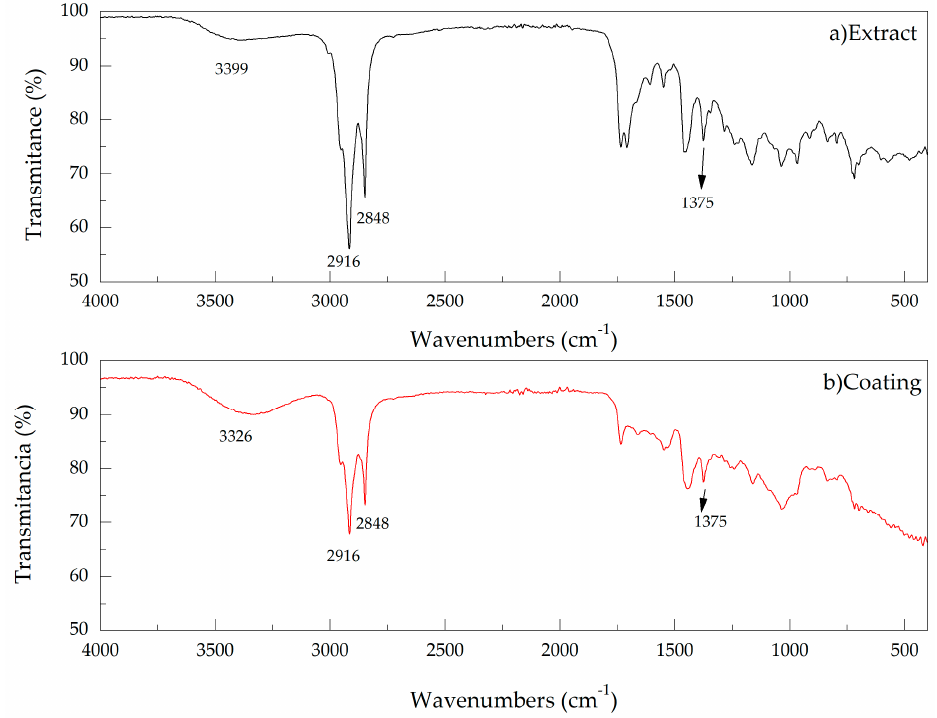
Figure 3. FTIR transmittance spectrum for ( a ) Artemisia vulgaris extract ( b ) coating of Artemisia vulgaris.